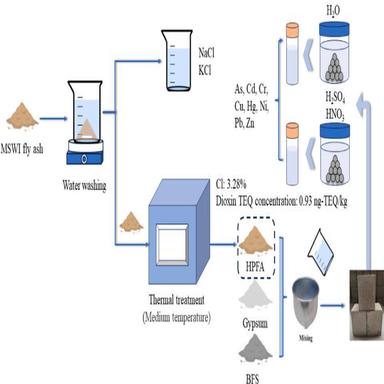
Experimental Process.